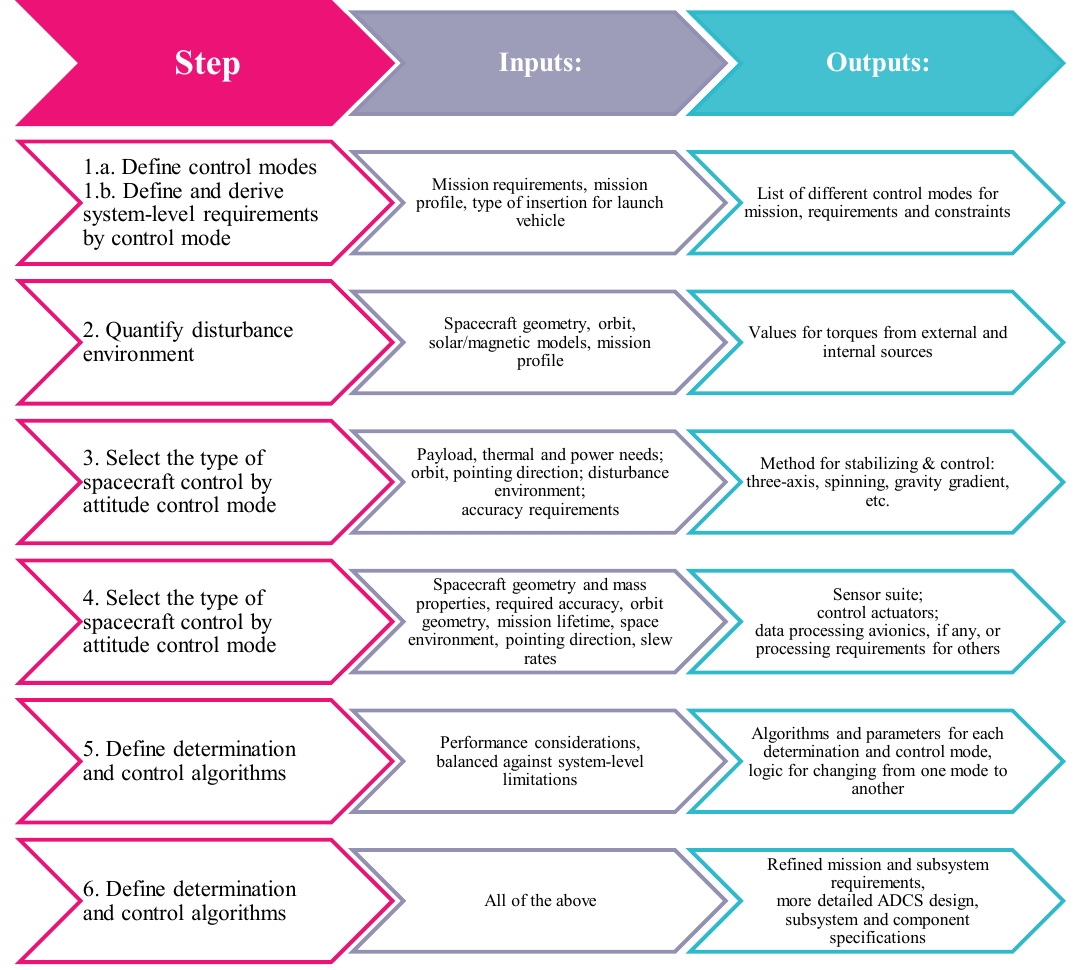
Fig. 3 . Design process of an Attitude Determination and Control System (ADCS). Fig. 3. Design process of an Attitude Determination and Control System (ADCS).